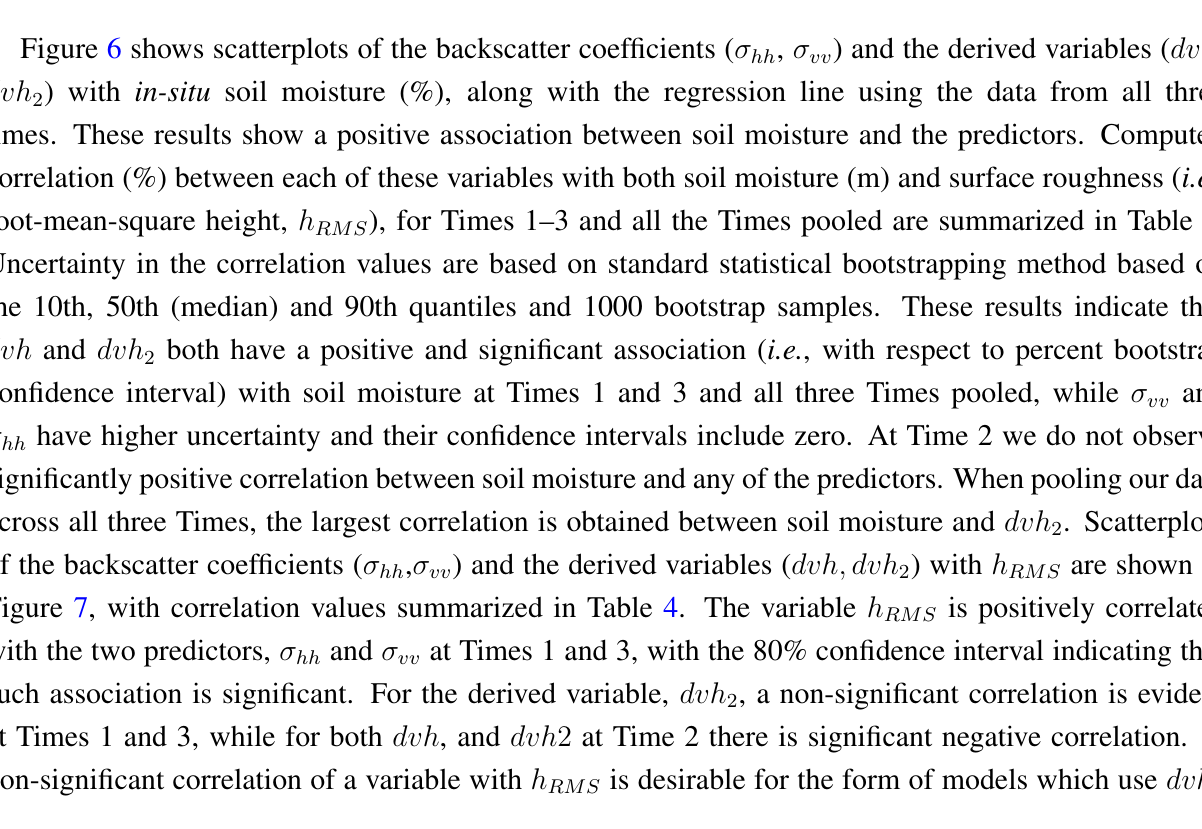
Figure 5. The relationship between ε obtained from Dubois formulas and the near-surface r soil moisture (m(%)). The left and middle panels correspond to the single polarization methods and the right panels correspond to the multi-polarization method. Associated regression lines are indicated: Time 1 (light grey); Time 2 (grey); Time 3 (black). The bottom panels correspond to the points for which the Dubois Conditions are